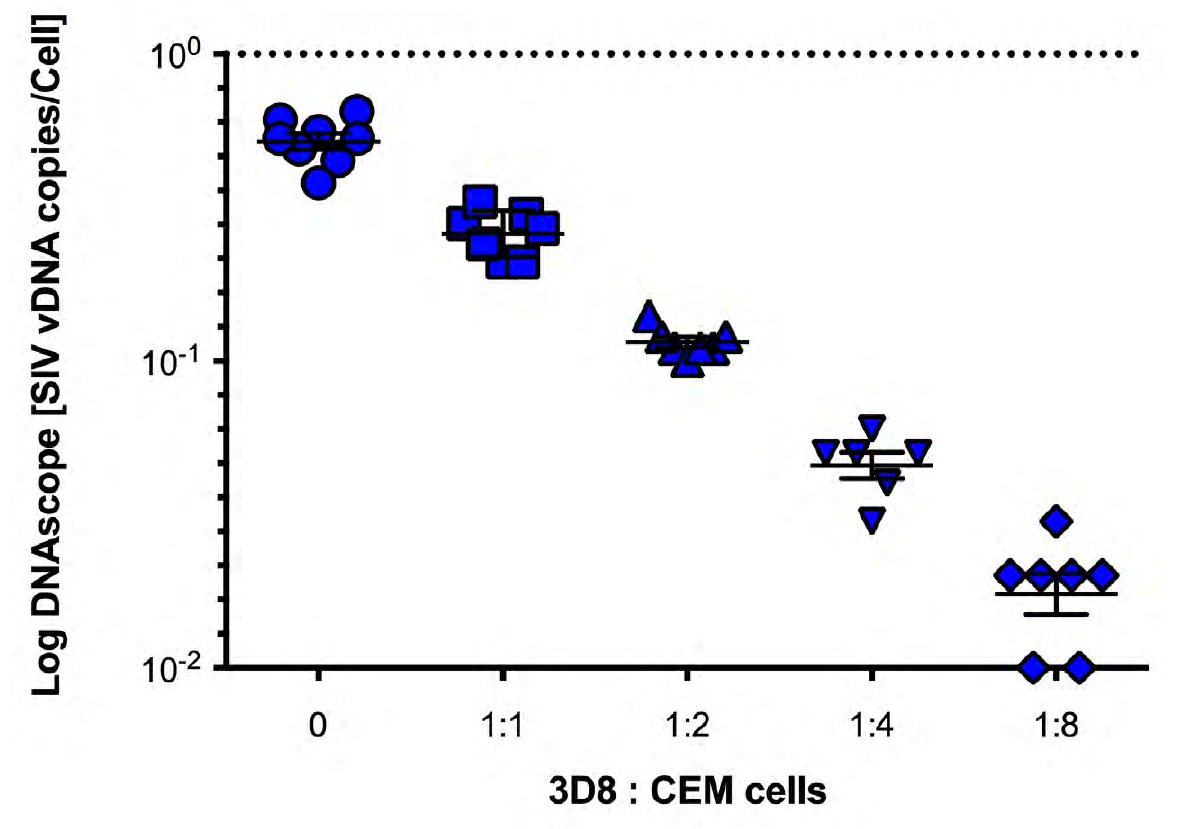
Supplemental Figure 4. DNAscope quantification of vDNA in 3D8 cells diluted in uninfected CEM cells. DNAscope was performed on 3D8 cells diluted into CEM cells. Each symbol represents an individual high magnification image quantified from a single experiment. One of three experiments